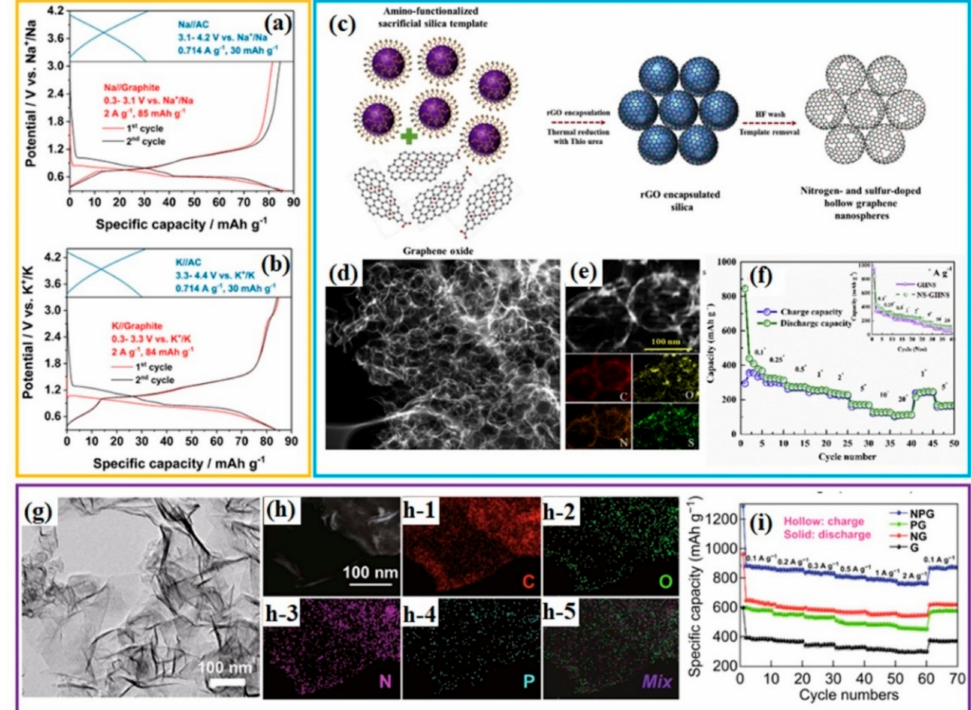
Figure 5. Graphite/graphene as anode for post-Li (Na + , K + ) hybrid capacitors: charge–discharge curves of graphite as anode in three-electrode ( a ) sodium half-cells and ( b ) potassium half-cells. Reproduced with permission [45]; Copyright 2019, American Chemical Society. ( c – f ) hollow sphere composite of N,S-doped graphene (NS-GHNS) for sodium-ion hybrid capacitors: ( c ) schematic illustration of the synthesis of NS-GHNS, ( d ) transmission electron microscope (TEM) image and ( e ) energy dispersive spectroscopy (EDS) mapping of NS-GHNS, ( f ) rate performance of NS-GHNS as anode in sodium half-cells; reproduced with permission [33], Copyright 2020, Elsevier. ( g – i ) N,P-doped graphene (NPG) as anode for potassium hybrid capacitors: ( g ) TEM image, ( h ) EDS mapping (h-1 to h-5 represent the distribution of C, O, N, P and all elements), and ( i ) rate performance of NPG at different current densities; (G, NG, and PN stand for graphene, N-doped graphene, and P-doped graphene, respectively) Reproduced with permission [46], Copyright 2019,